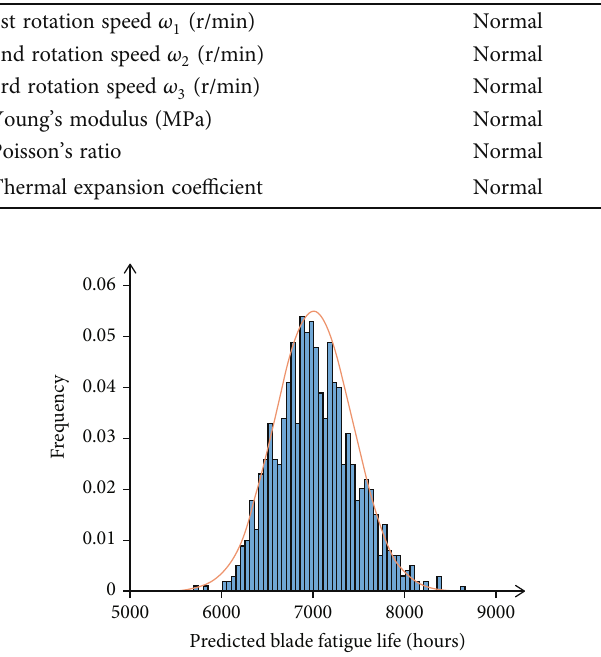
Figure 8: Distribution of fatigue life samples (Monte Carlo method).